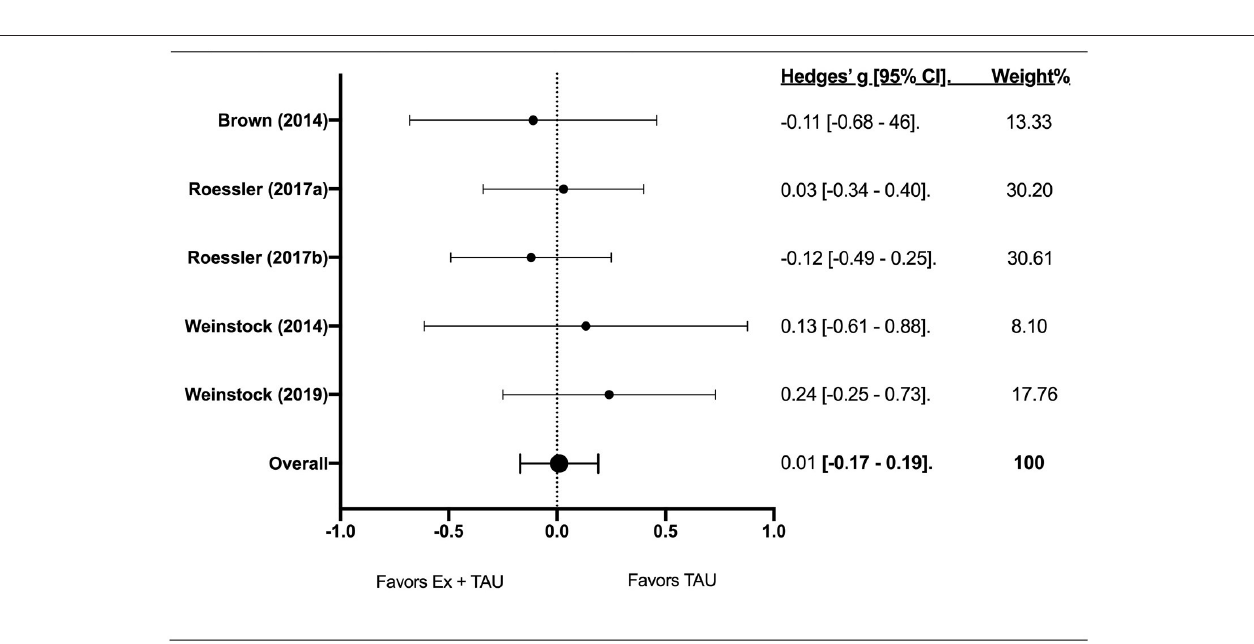
FIGURE 3 | The forest plot about the effect of exercise on binge